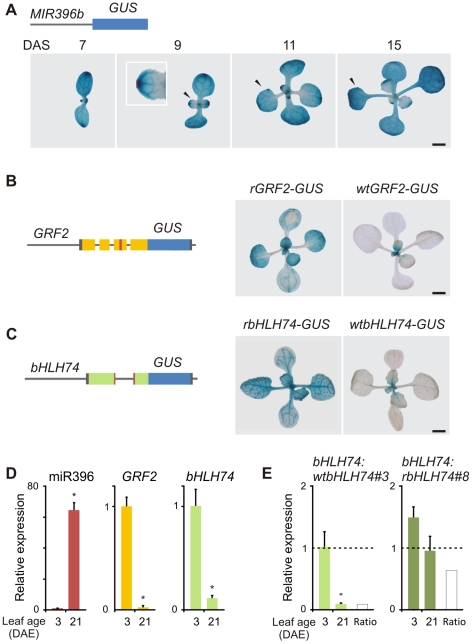
MiR396 coordinates the spatio-temporal expression of bHLH74 and GRF2.(A) GUS staining of MIR396b:GUS plants of different age. Arrowheads show leaf #1. Numerals indicate plant age expressed in DAS (Days After Sowing). The inset shows a closer look at a developing leaf displaying a miR396 expression gradient. (B) GUS staining of wtGRF2-GUS (right) and rGRF2-GUS lines (15-day old). rGRF2-GUS has synonymous mutations in the miR396-target site. Left, scheme representing the reporters. The upstream regulatory regions and the first 4 exons were fused to GUS. The miRNA-target site is indicated in red. (C) GUS staining of wtbHLH74-GUS (right) and rbHLH74-GUS lines (15-day old). rbHLH74-GUS has synonymous mutations in the miR396 target site. Left, scheme representing the reporters. The upstream regulatory regions and the first 2 exons were fused to GUS. The miRNA target site is indicated in red. (D) miR396, GRF2 and bHLH74 RNA levels estimated by RT-qPCR in wild-type leaf #5 (DAE: Days After leaf #5 Emergence). Data shown are mean ± SEM of 3 biological replicates. Asterisks indicate significant differences between leaves, as determined by ANOVA (P<0.05). (E) bHLH74 expression levels at different ages of leaf #5 in bHLH74:wtbHLH74 and bHLH74:rbHLH74 plants. Expression levels were normalized to 3 DAE of the bHLH74:wtbHLH74 line #3. Data are mean ± SEM of 3 biological replicates. Asterisks indicate significant differences between leaves, as determined by ANOVA (P<0.05). Scale Bars: 2 mm.